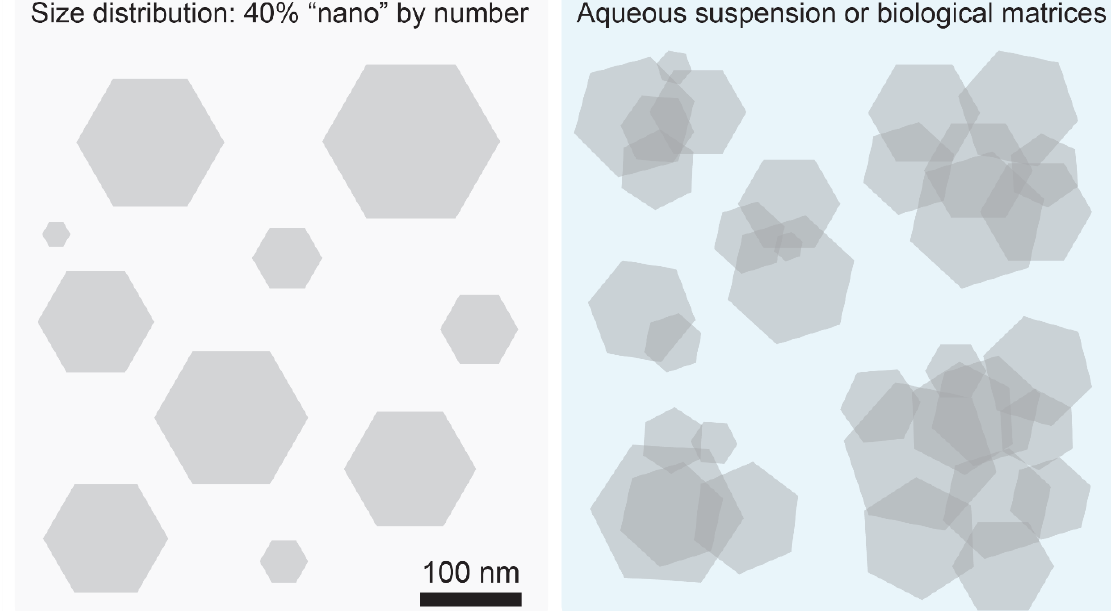
Figure 1: E171 assembles into particle clusters. Scheme illustrating how a population of particles consisting of 40 % “nano” by number (panel on the left; mean diameter of particles: 125 nm) forms larger clumps by aggregation/agglomeration in an aqueous suspension or biological matrices (panel on the right), thus nullifying the “nano” properties of the